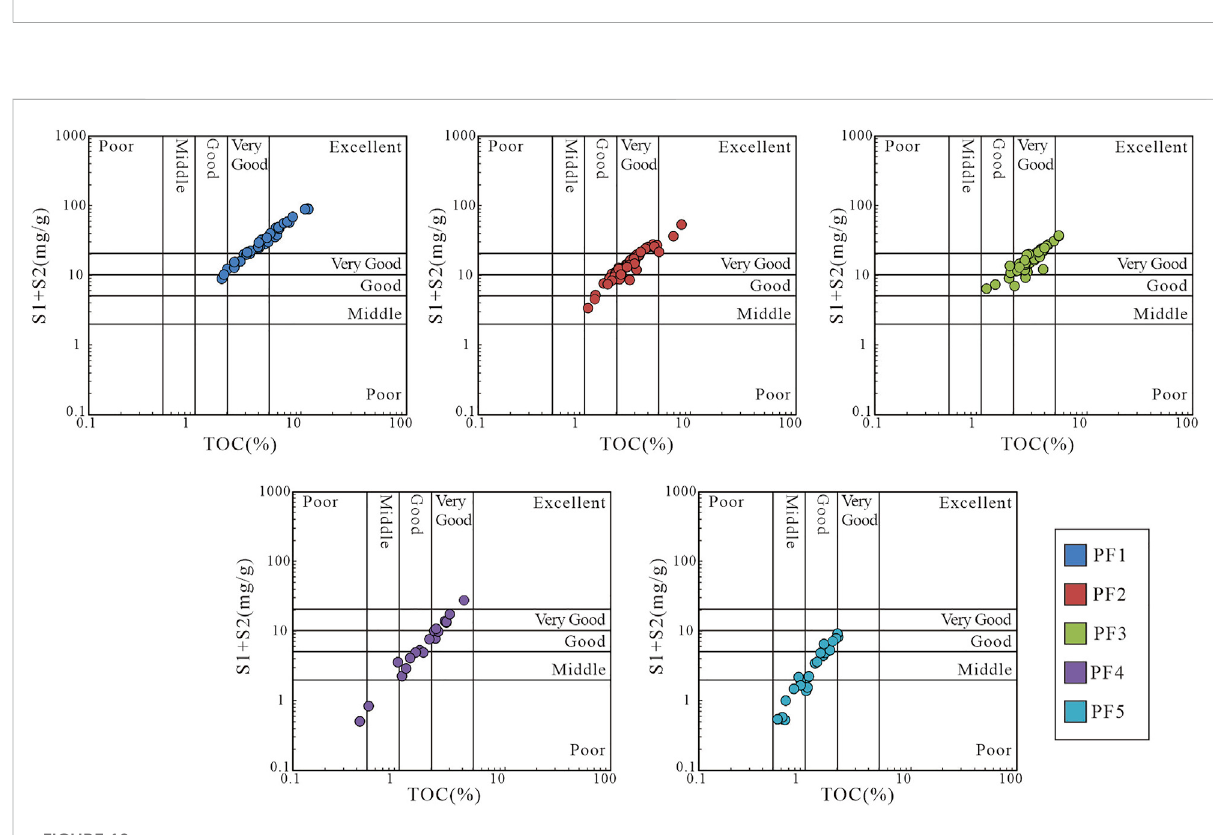
FIGURE 10 Hydrocarbon generation potential of palynofacies (according to Peters,